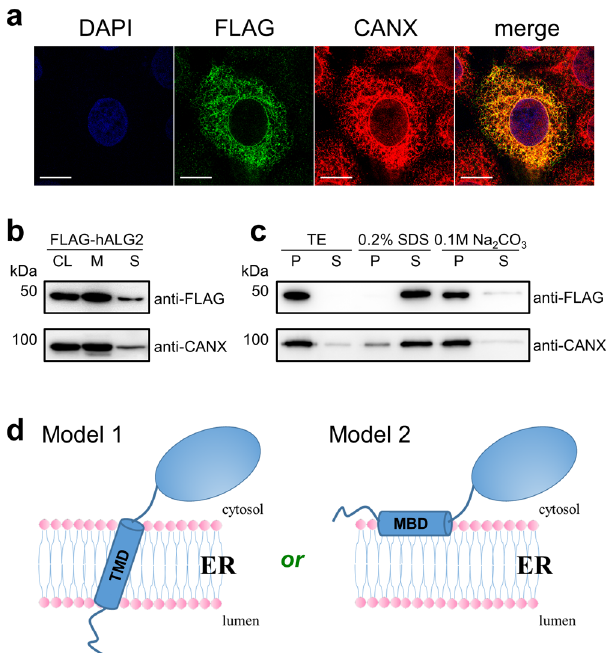
Fig. 1 Subcellular localization of hAlg2 protein. a Immuno fl uorescence of FLAG-tagged hAlg2 protein. HEK293 cells transiently expressing N-terminally FLAG-tagged hAlg2 were doubly immunostained for FLAG and ER marker CANX (Calnexin), followed by Alexa Fluor 488-conjugated anti-mouse and Alexa Fluor 555-conjugated anti-rabbit secondary antibodies. Images were obtained by confocal microscopy. Nuclei were stained with DAPI (blue). Green indicates FLAG-hAlg2. Red indicates CANX. Merge indicates co-localization. Bar, 20 µ m. b Fractionation of FLAG-hAlg2 and detected by western blotting. CL represents cell lysate, M represents membrane proteins, S represents soluble proteins. c Membrane extraction of FLAG-hAlg2 protein. The membrane fraction was treated with 0.2% SDS or 0.1 M Na 2 CO 3 (pH 11) and further centrifuged at 100,000 × g to separate membrane and soluble proteins. Equivalent amounts of proteins from the pellet (P) and supernatant (S) were compared by western blotting. d Putative topological models of hAlg2 on the ER.